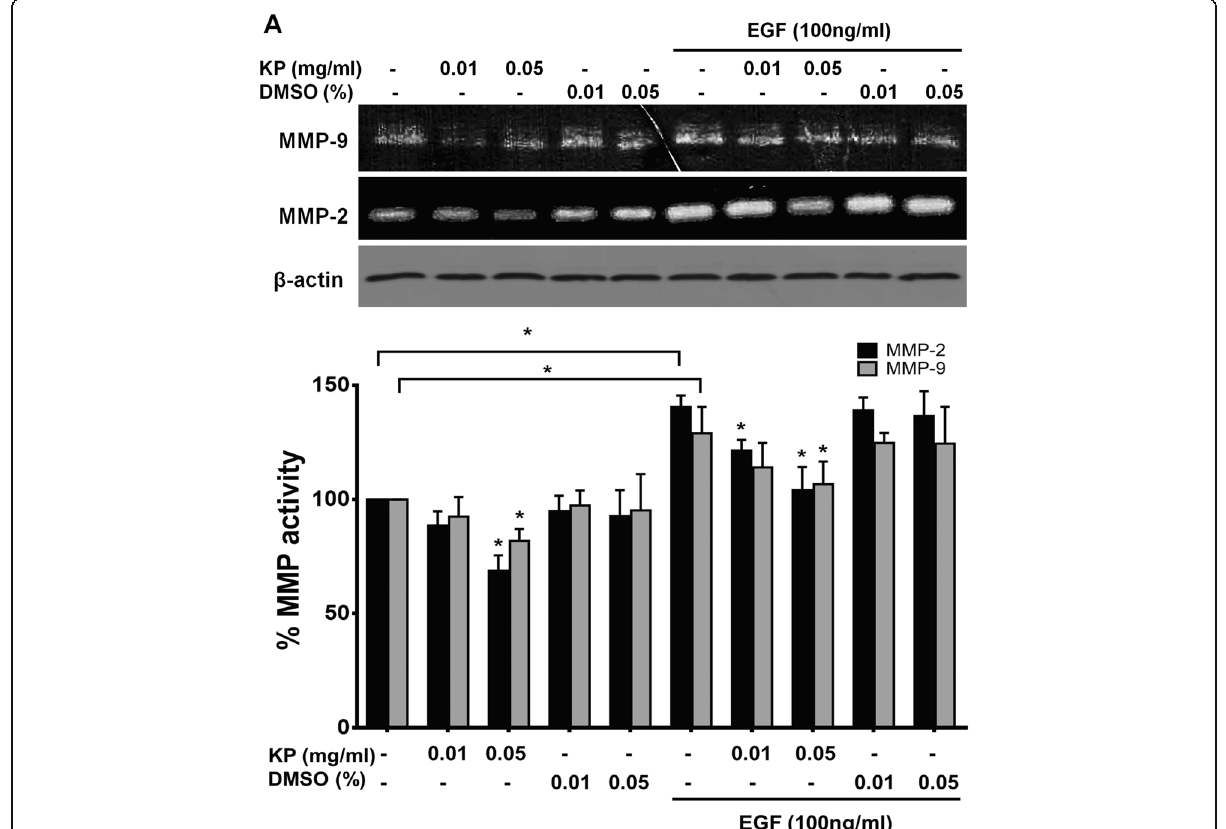
Fig. 3 The effect of KP ethanol extract on MMP-9 and MMP-2 activity. Gelatin zymogram showing MMP9 and MMP2 activities ( a ), Immunoreactive bands of β -actin was used as a loading control. Histogram of MMP-2 and MMP-9 activity is presented as percent of activity ( b ). All data were from 3 independent experiments. * P <